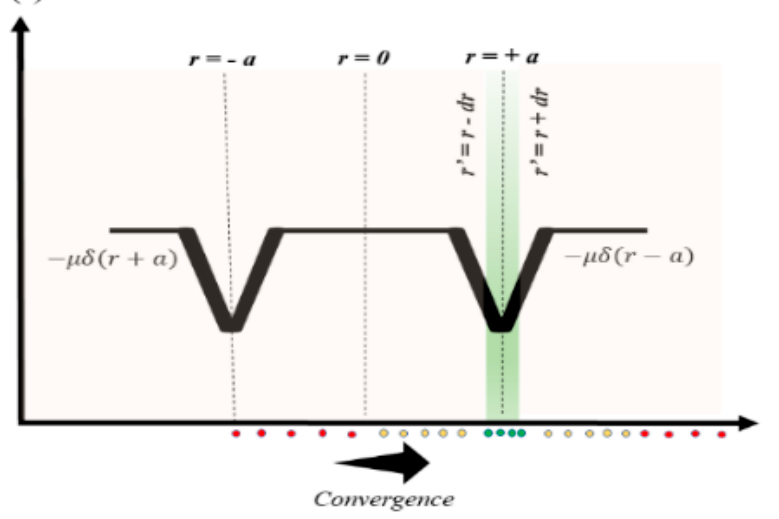
Figure 1. The double well potential setup.